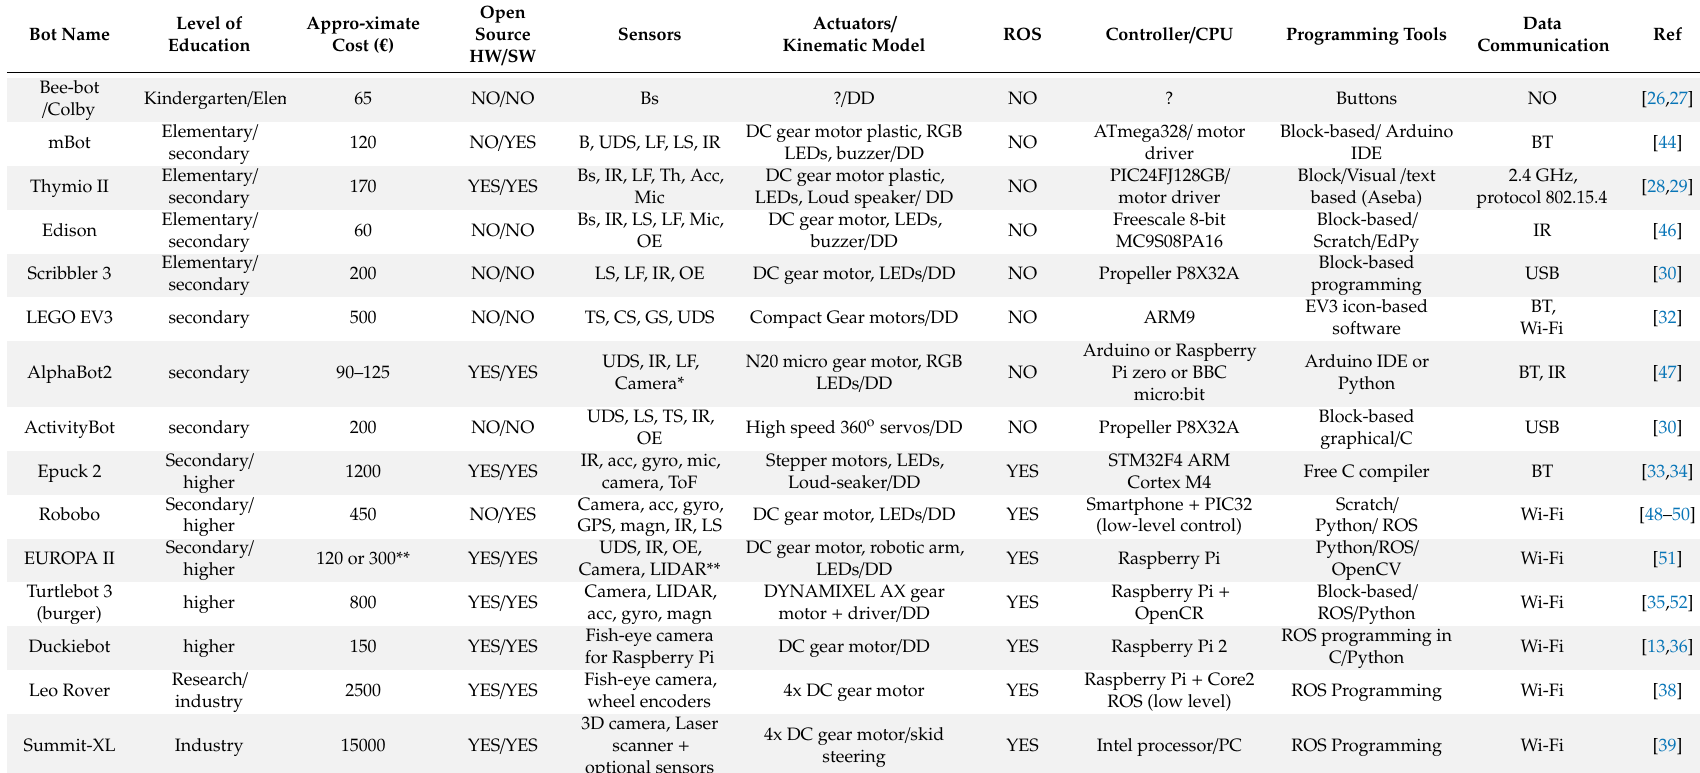
Table 1. Most widespread mobile educational platforms: target group, cost and